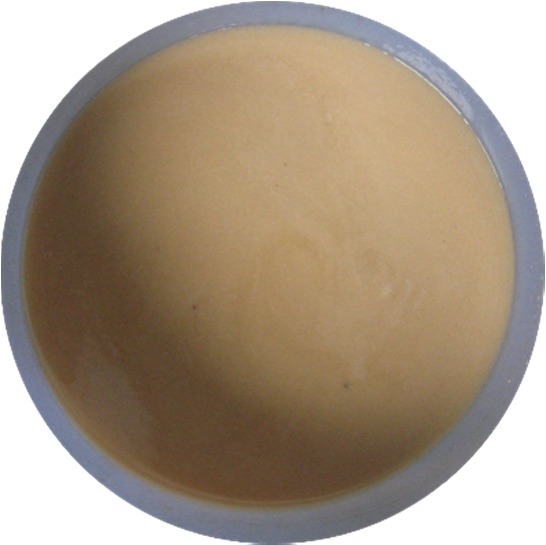
Appearance of corrosion solution at H2S content of 2000 ppm.